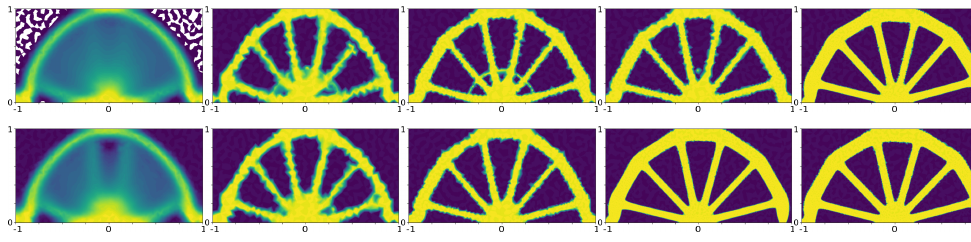
n + 100 ( bottom row ).